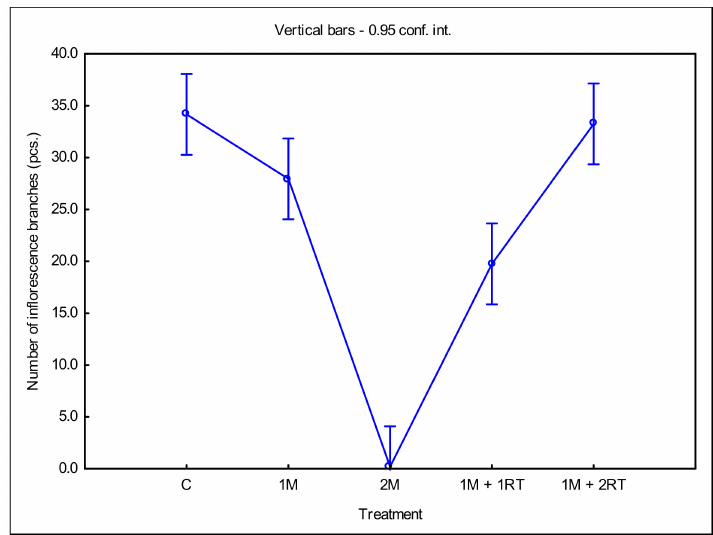
Figure 12. Mean number of inflorescence branches per single goldenrod shoot, depending on the type of mechanical treatment. The following symbols denote the research treatments: C: control; 1M: one-time mowing; 2M: two-time mowing; 1M + 1RT: one-time mowing with one-time rotary tilling; 1M + 2RT: one-time mowing with two-times rotary tilling. In the case of the 1M + 2RT treatment, the inflorescence branches were reduced by 14 units compared to the control